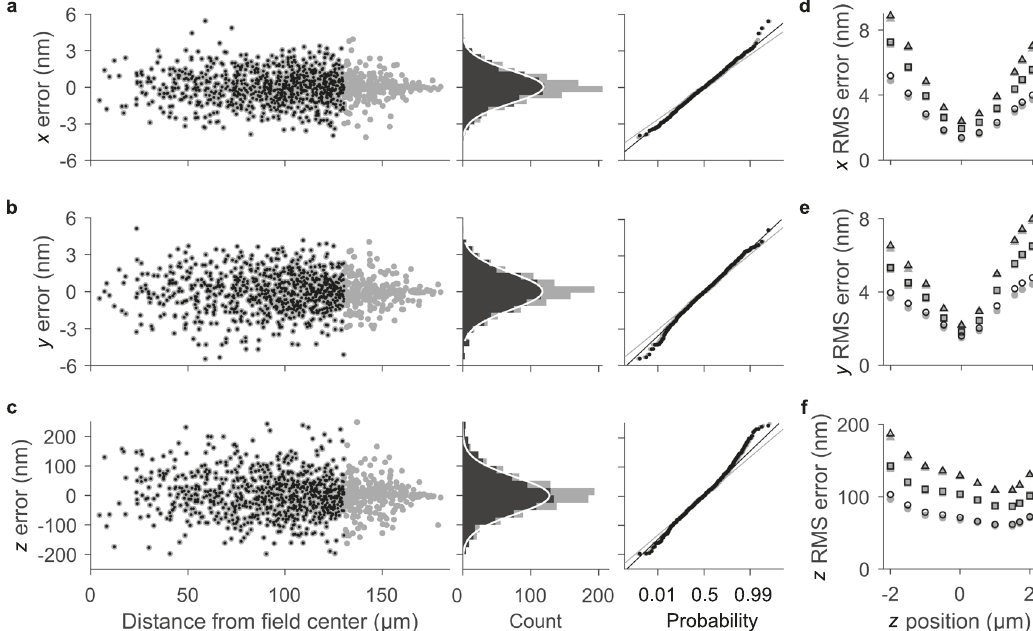
Fig. 5 Localization error throughout a deep and ultrawide fi eld. Gray data include calibration particles from the full square fi eld and black data include only the particles within a subset circular fi eld. a – c Scatter plots, histograms, and normal probability plots of the differences between local and wide fi eld calibration functions for each calibration particle, which de fi ne the error of wide fi eld calibration, at the z = 0 focal surface for ( a ) x , ( b ) y , and ( c ) z . The scatter plots show these errors as a function of the distance of each particle from the nominal center of the fi eld. Histograms include a (white line) Gaussian model fi t to the black data. d – f Plots showing root-mean-square (RMS) error as a function of z position for wide fi eld calibration of ( d ) x , ( e ) y , and ( f ) z , using (triangle) nearest-neighbor interpolation, (square) natural-neighbor interpolation, and (circle) Zernike polynomials. Uncertainties in ( d – f ) are smaller than the data